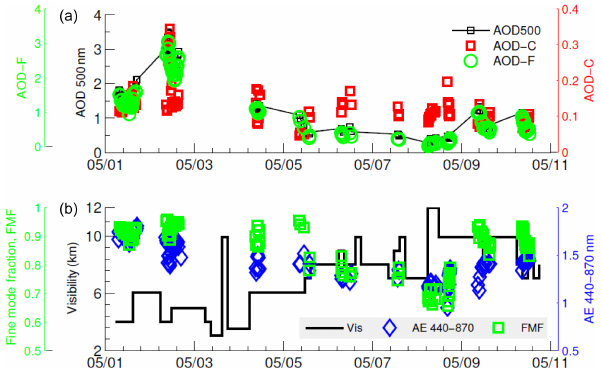
Figure 3. AOD and other data products from the Level 1.5 AERONET direct product in the Pokhara Valley from 1 to 10 May 2016. The top panel includes AOD at 500nm and the AOD for coarse and fine modes (as shown in the figure above as AOD- C and AOD-F). The bottom panel includes the Ångström expo- nent (AE) for 440–870nm, the fine-mode fraction, and the visibility (km). The visibility data were available from the synoptic meteo- rology data available at http://www7.ncdc.noaa.gov/CDO/cdo (last access: 3 July